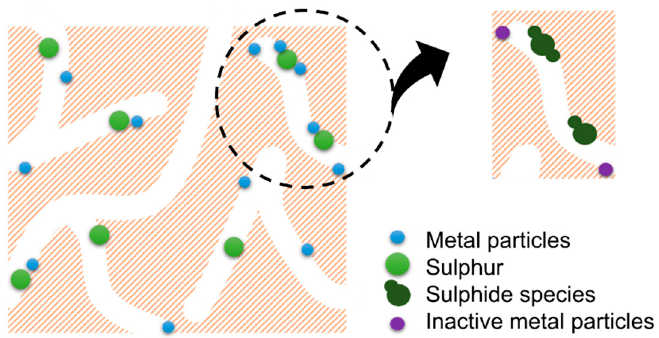
Figure 2. Schematization of the poisoning effect of sulfur on catalysts.